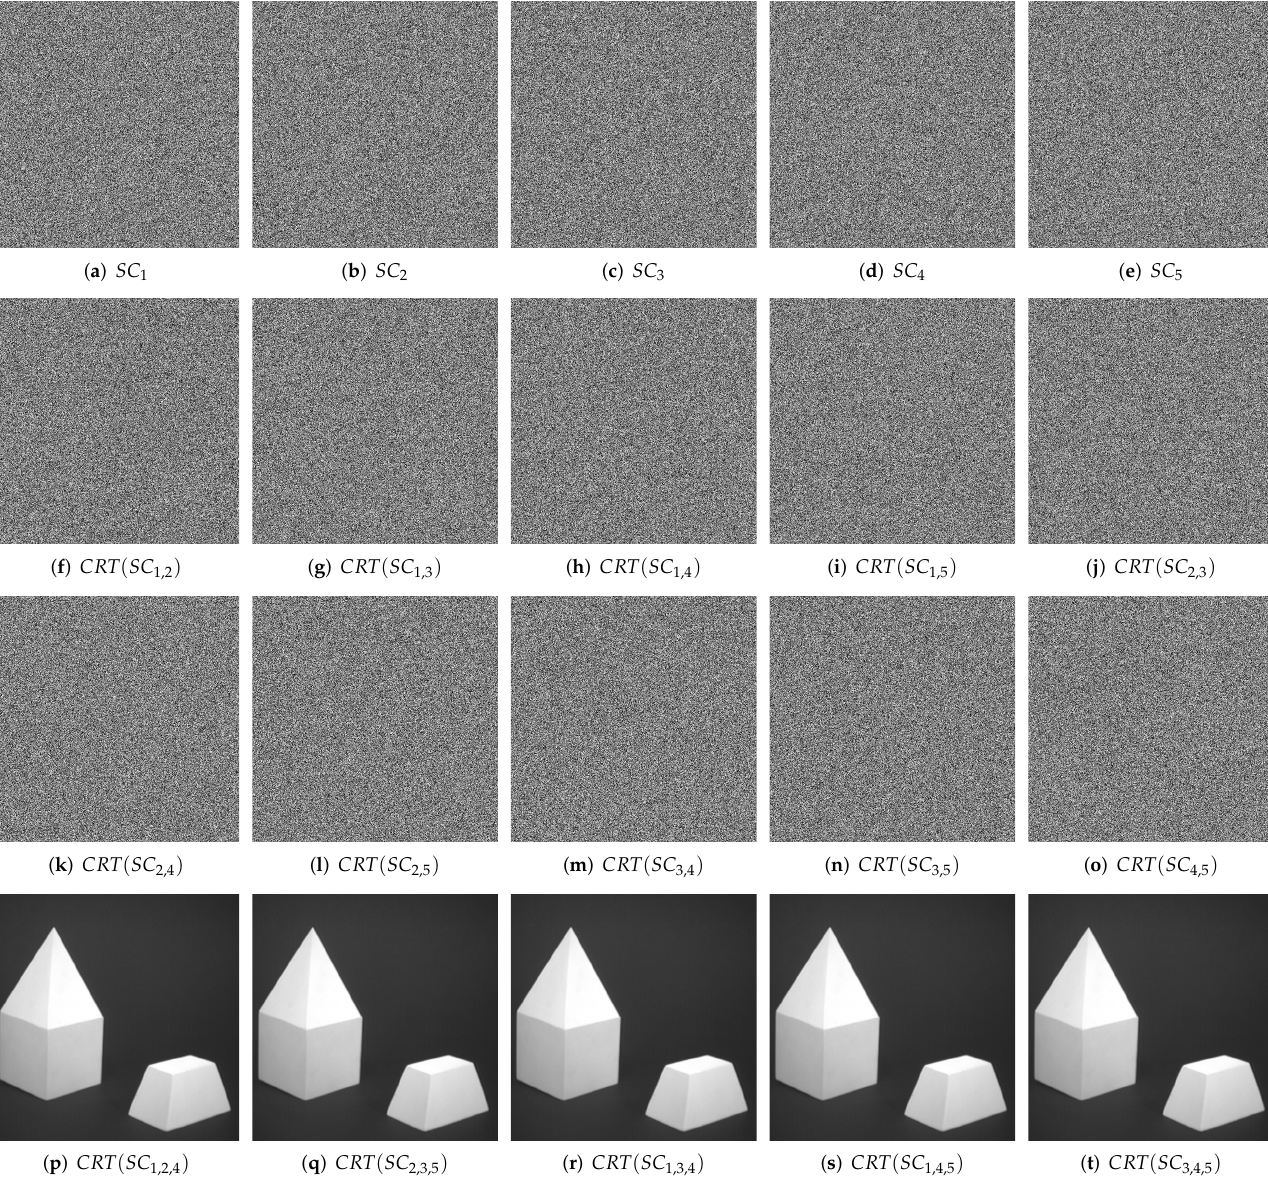
Figure 5. Experimental results of the introduced scheme for the ( 3,5 ) threshold. ( a – e ) Five generated shares SC 1 , SC 2 , SC 3 , SC 4 and SC 5 ; ( f – o ) recovered images with two shares; ( p – t ) recovered images with three